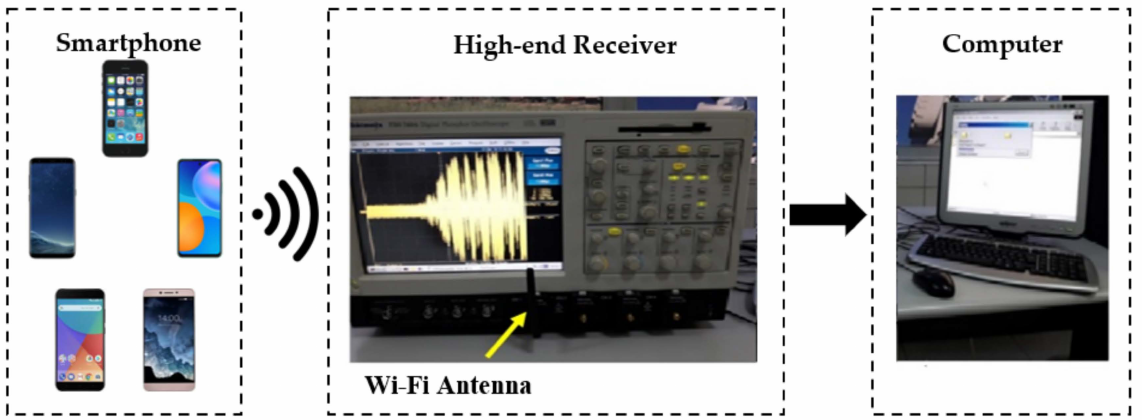
Figure 2. Data acquisition